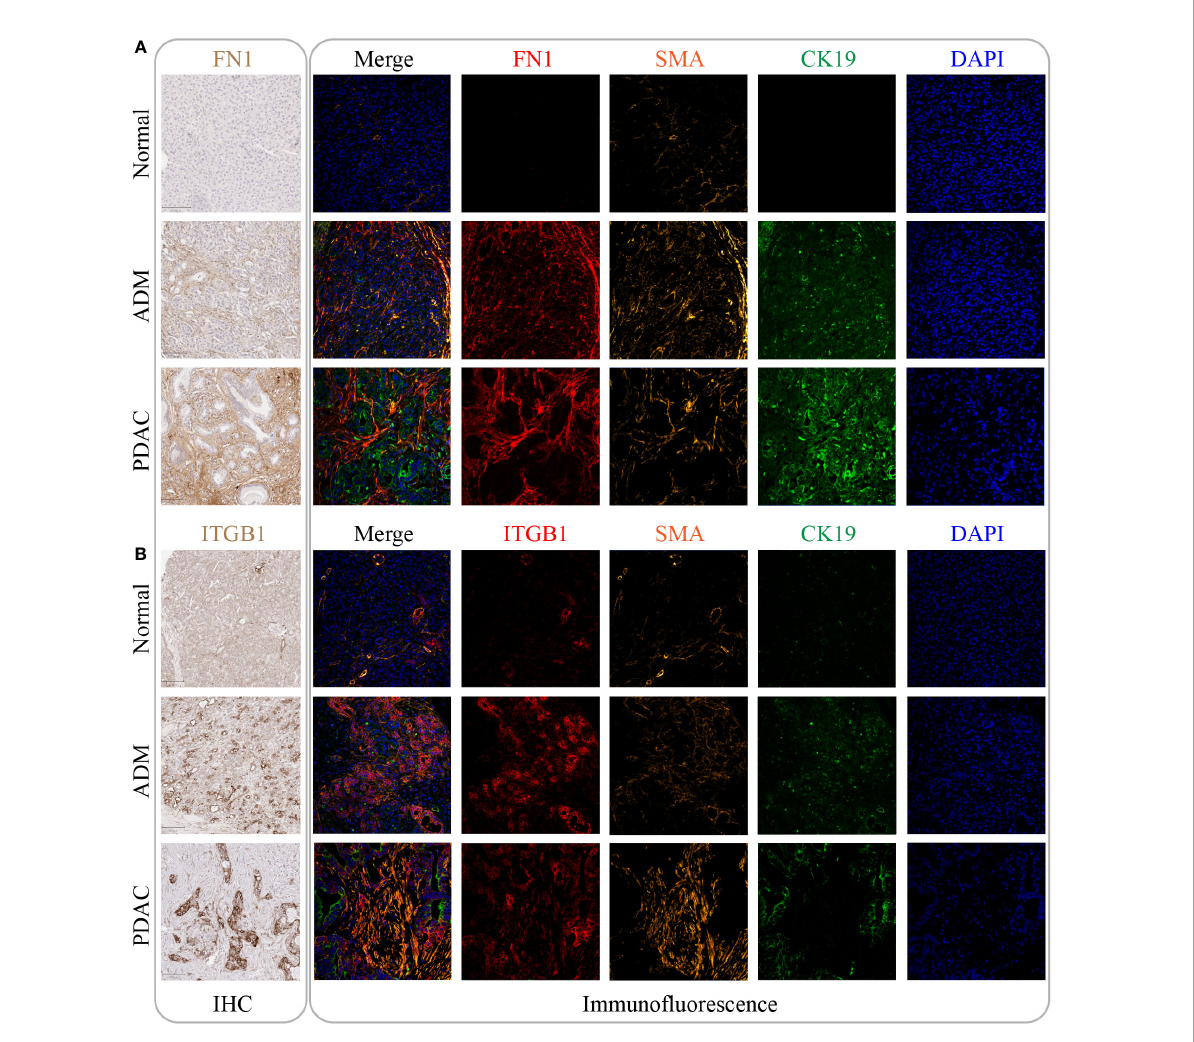
FIGURE 7 The expression of FN1 and ITGB1 in normal tissue, ADM tissue and PDAC tissue. (A) The expression of FN1 was gradually increased by IHC and immuno fl uorescence. Its expression location was mainly in the intercellular substance. (B) The expression of ITGB1 was gradually increased by IHC and immuno fl uorescence. Its expression location was mainly inside the cancer